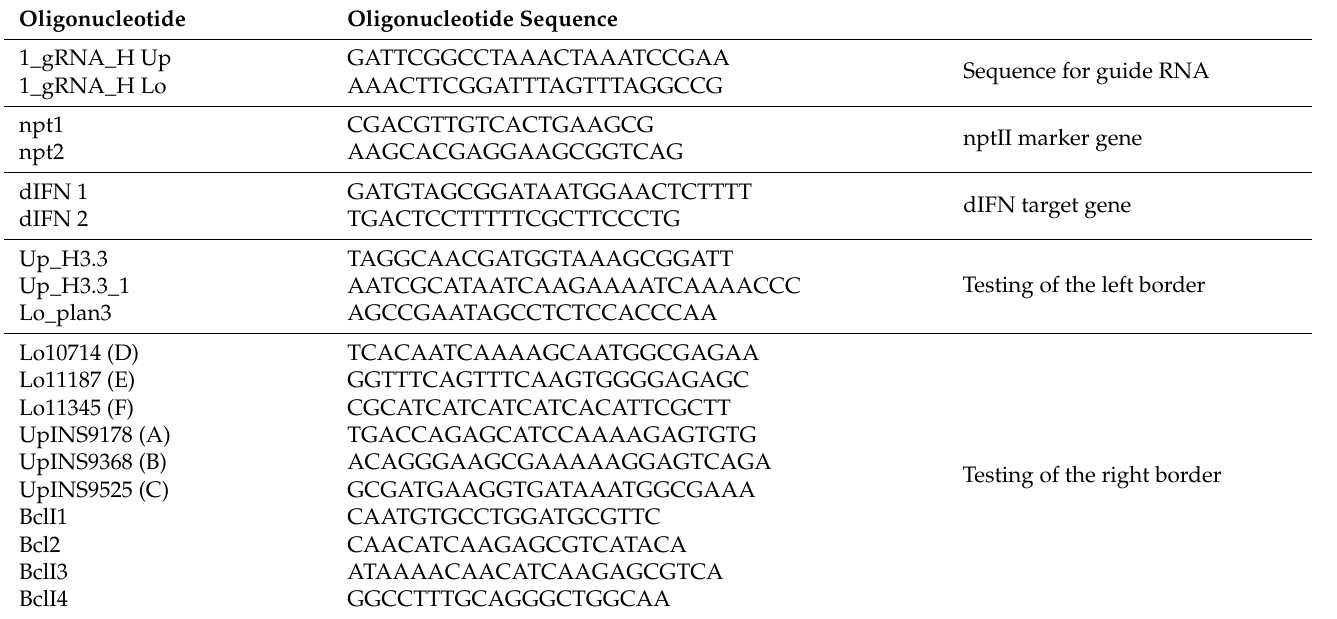
Table 1. Oligonucleotides used in the